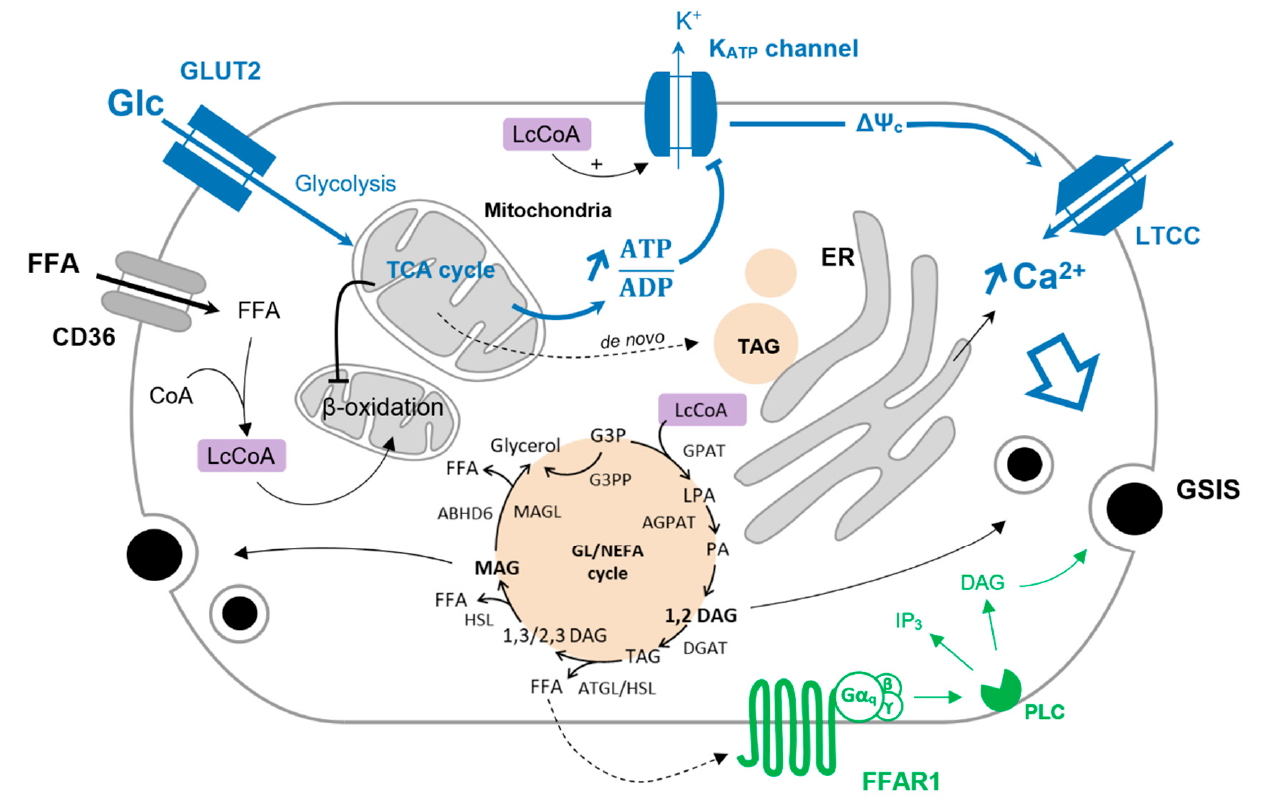
Figure 1. Glucose-induced FFA partitioning in the β -cell. Inhibition of β -oxidation by glucose (Glc) redirect Lc-CoA to the GL/NEFA cycle. Condensation of glycerol-trisphosphate and Lc-CoA is mediated by the glycerol-3-phosphate O-acyltransferase (GPAT) to form lysophosphatidic acid (LPA). LPA is further acetylated into phosphatidic by the 1-acyl-sn-glycerol-3-phosphate acyltransferase (AGPAT). The phosphohydrolase activity of lipins on PA produces 1,2-DAG that is then converted to TAG by the diacylglycerol O-acyltransferase (DGAT). TAG is sequentially hydrolyzed to 1/2,3- DAG, MAG, and finally glycerol by the adipose triglyceride lipase (ATGL), the hormone-sensitive lipase (HSL), and the MAG lipase (MAGL). MAG can also be hydrolyzed to glycerol by the α / β -hydrolase domain-containing 6 lipase (ABHD6—plasma membrane-bound enzyme). G3P can be directly converted to glycerol via the glycerol-3-phosphate phosphatase (G3PP) as a mechanism of gluco-detoxification. The triggering pathway of insulin secretion is shown in blue. Activation of FFAR1 further enhances insulin secretion, as shown in green.